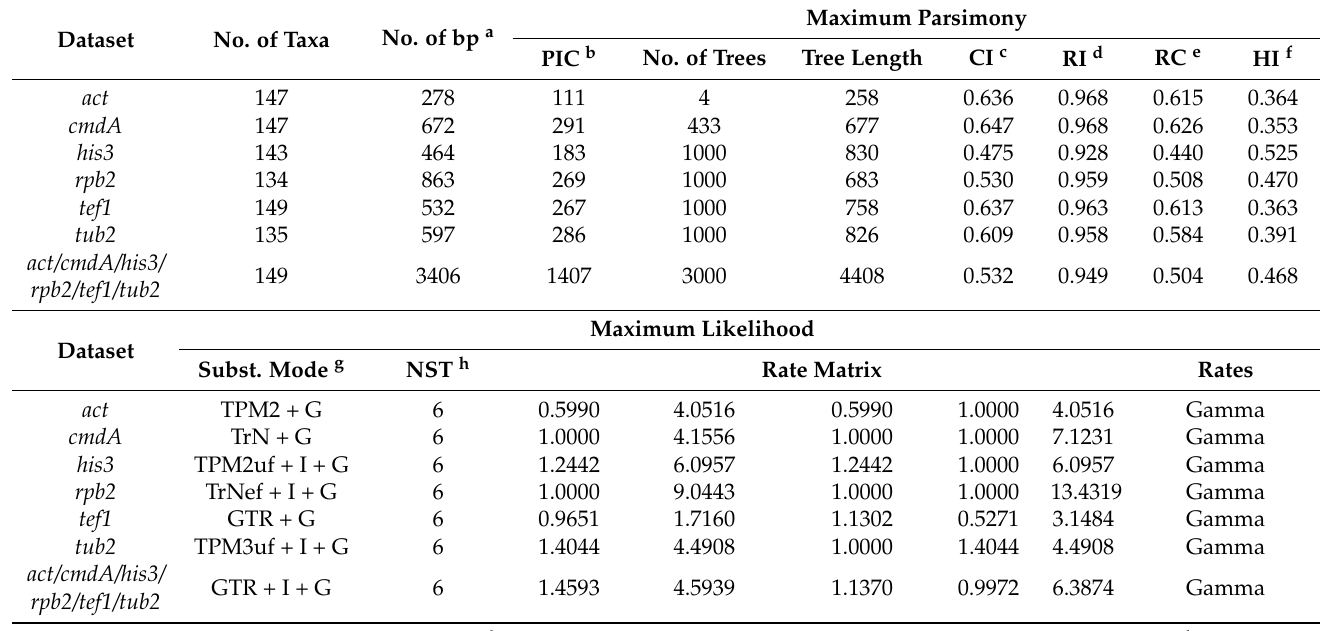
Table 4. Statistics resulting from phylogenetic analyses in this